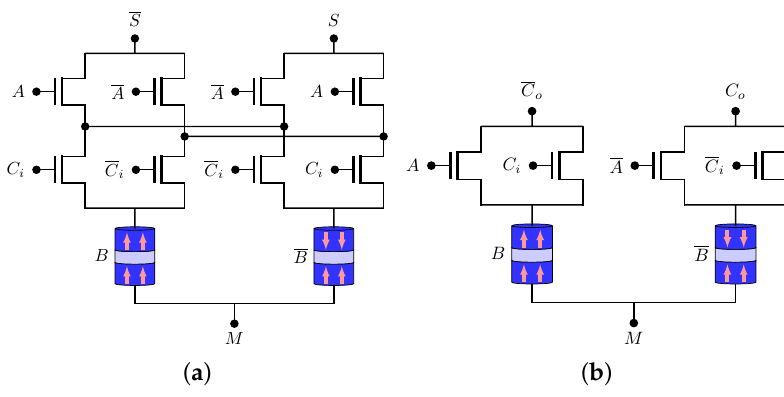
Figure 11. Full adder structure: ( a ) SUM sub-circuit ( b ) CARRY sub-circuit.